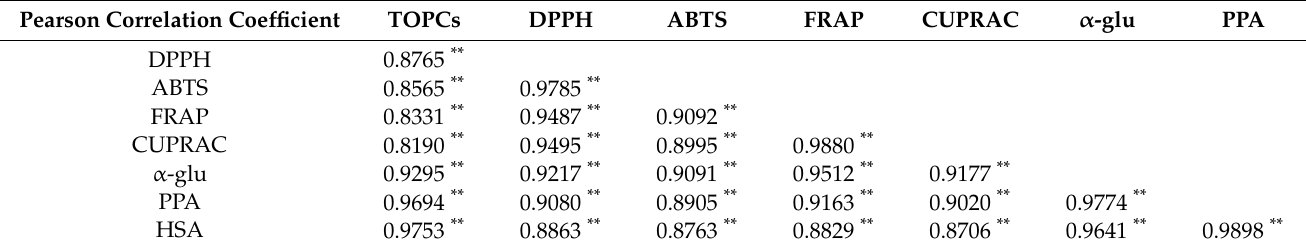
Table 4. The Pearson correlation coefficient between TOPCs, and antioxidant and antidiabetic activity. Pearson Correlation Coefficient TOPCs